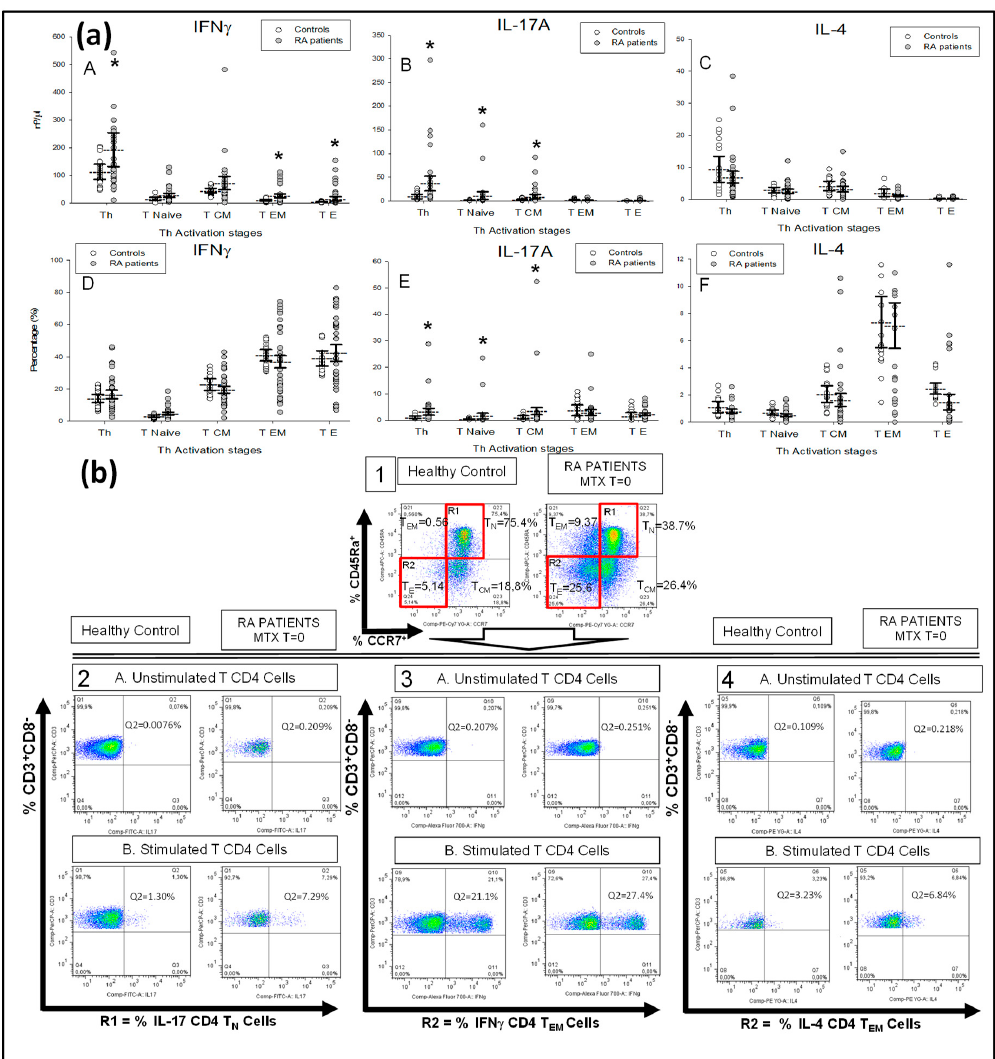
Figure 1. Intracellular IFN γ , IL-17A, IL-4 expression by the different activation/differentiation stages of T CD4 + lymphocytes from rheumatoid arthritis (RA) patients. Note: ( a ) Data represent numbers (nº/ γ l) (A, B and C panels) and percentages (%) (D, E and F panels) of total CD3 + CD4 + (Th), and the T Naïve , T CM , T EM and T E CD4 + lymphocyte subsets that express intracellular IL-17A, IFN γ and IL-4 after in vitro phorbol-12-myristate-13-acetate (PMA) stimulation in disease-modifying antirheumatic drug (DMARD)-naïve RA patients ( ) and healthy controls ( ). % (percentages) refers to total population of the indicated lymphocytes. All values are expressed as the mean cell numbers ± S.E.M. *, p < 0.05 for RA patients vs. healthy controls. ( b ) Panel 1. The first dot plots represent the selected gates and percentages of T N , T CM , T EM and T E CD4 + T-lymphocytes in two representative situations: a healthy control and RA patient at baseline before Methotrexate (MTX) treatment. Panel 2, 3 and 4. Dot plots represent the percentages of IL-17A, IFN γ and IL-4-producing CD4 + T cells in the presence and absence of PMA stimulation in the two representative cases described in panel 1. R1 and R2 represents the regions that include the T Naïve and T EM CD4 + lymphocyte subsets, respectively. Interestingly, the numbers of T N and T MC CD4 + T-lymphocytes expressing both IL-17A and IFN γ were significantly increased in patients compared with HCs (Figure 2a).